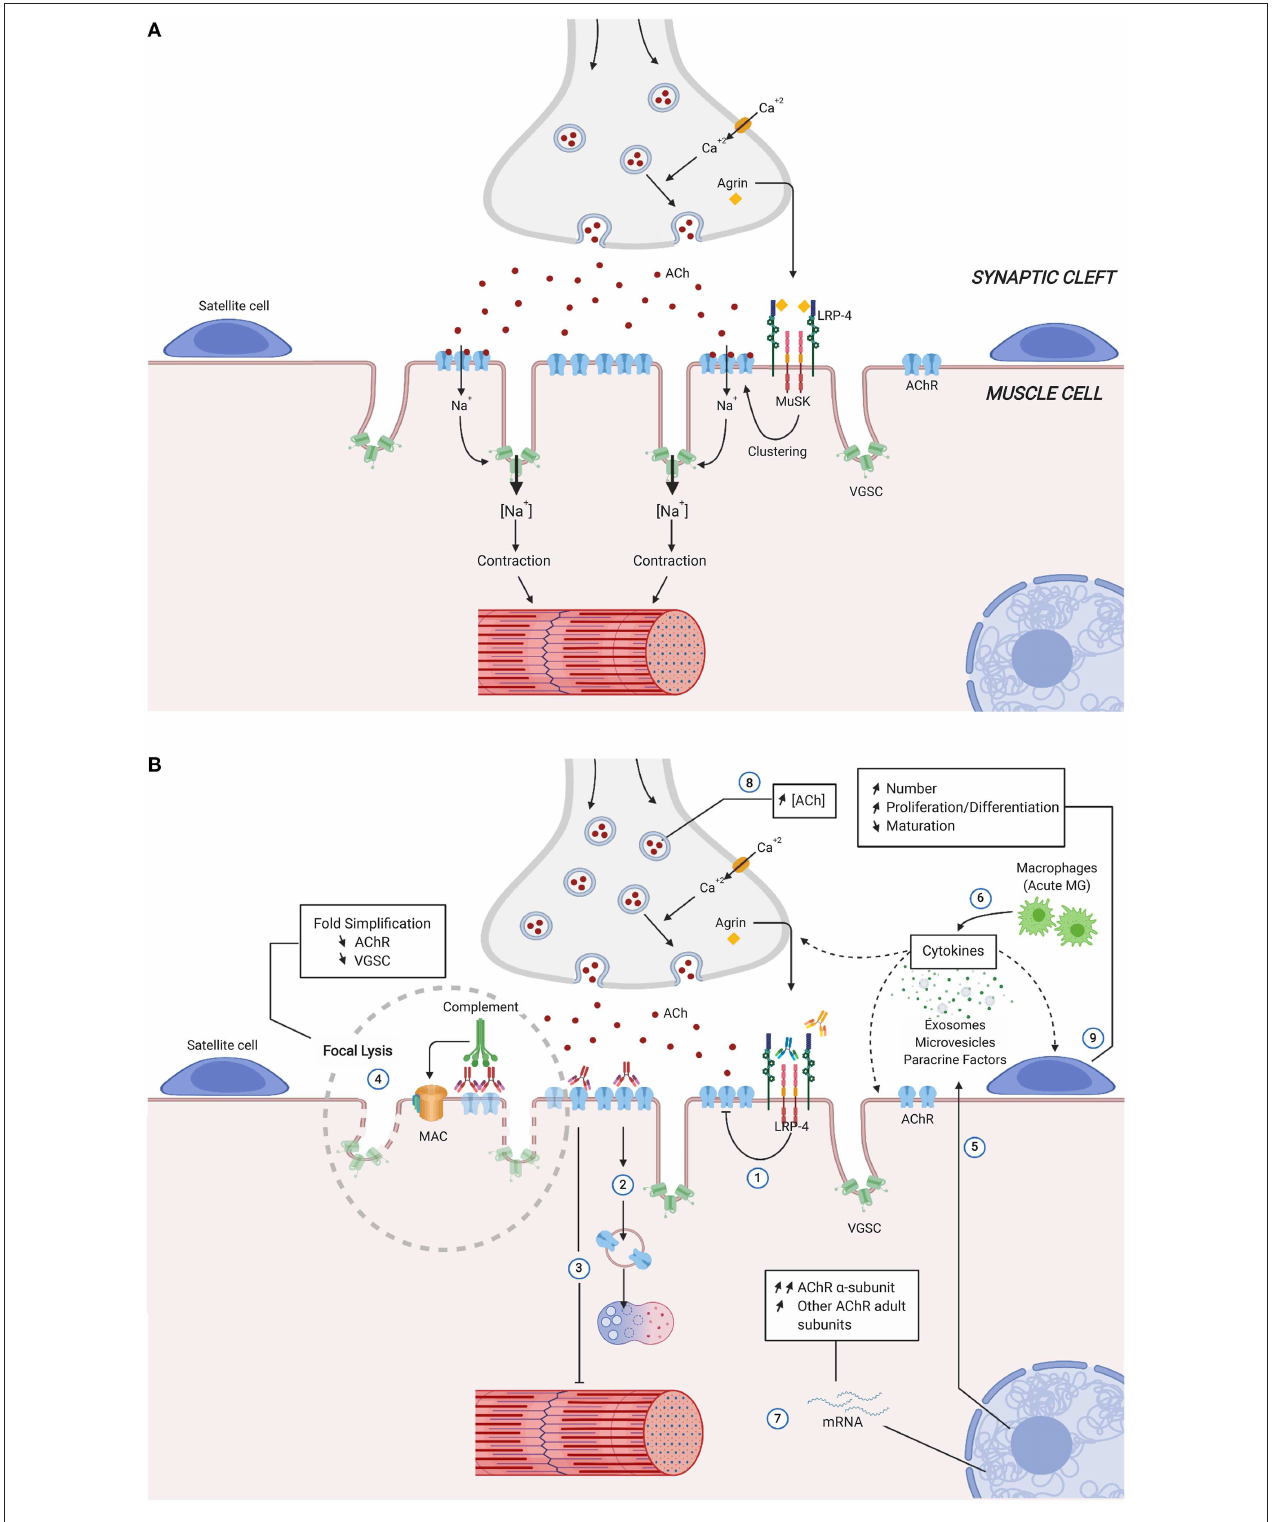
FIGURE 1 | Simplified structure and function of the neuromuscular junction (A) and physiological Changes in autoimmune Myasthenia Gravis (B) . Direct, indirect consequences of the various autoantibodies and compensatory mechanisms, are identified by numbers. Anti-MuSK and anti-LRP 4 autoantibodies act mainly